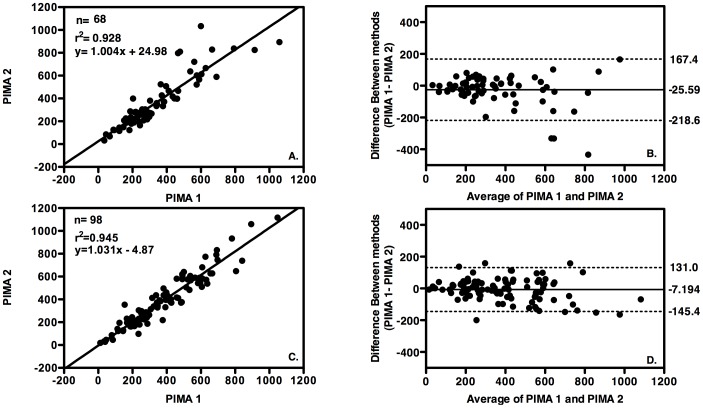
Operator Precision of PIMA testing.Linear regression analysis plots (right column) and Bland Altman bias plots (left column) with upper and lower 95% limits of agreement (LOA) shown as broken lines and mean bias shown as an unbroken line. A and B PIMA 1 operated by laboratory technicians at an urban (reference) laboratory, versus PIMA 2 operated by clinicians at an urban clinic, C and D PIMA 1 operated by laboratory technicians a rural laboratory compared to PIMA 2 operated by clinicians at 2 rural clinics.